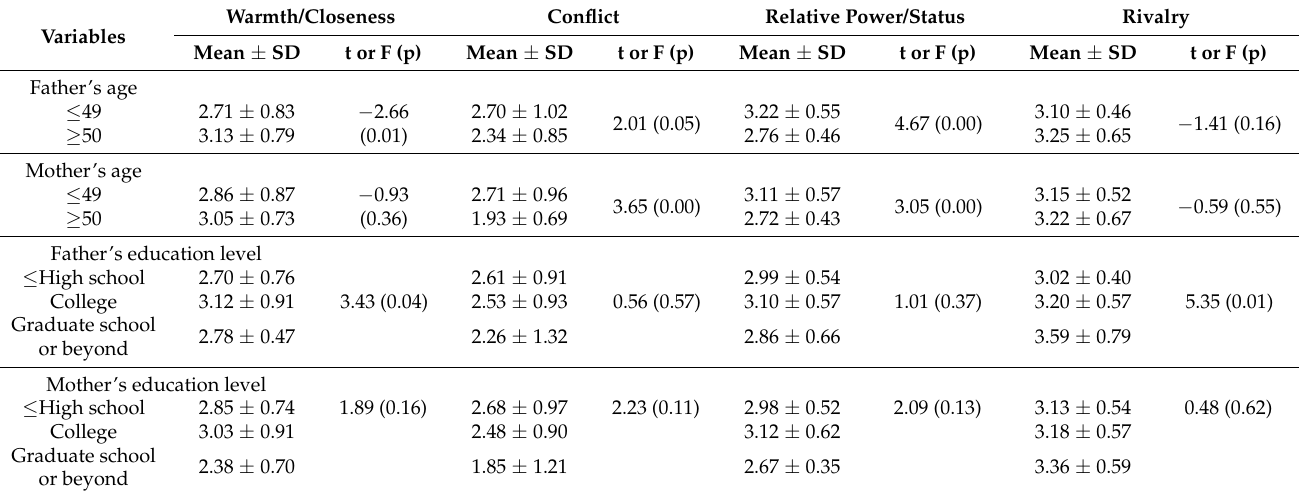
Table 4. Sibling relationships according to characteristics of parents and